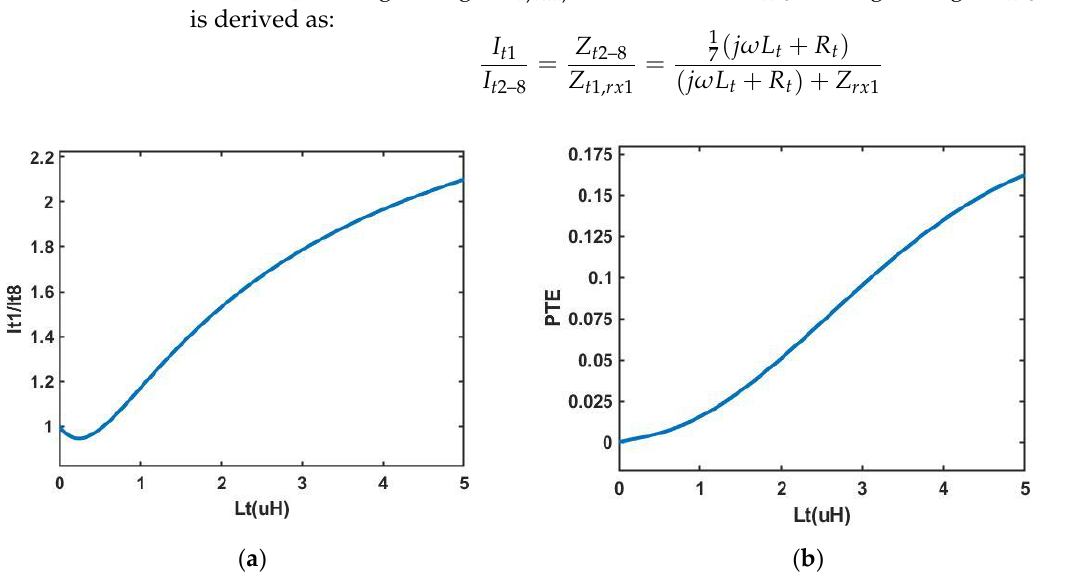
Figure 5. ( a ) The relationship between L t (the inductance of textile coil) and the current ratio I t 1 / I t 8 ; ( b ) The relationship between L t and